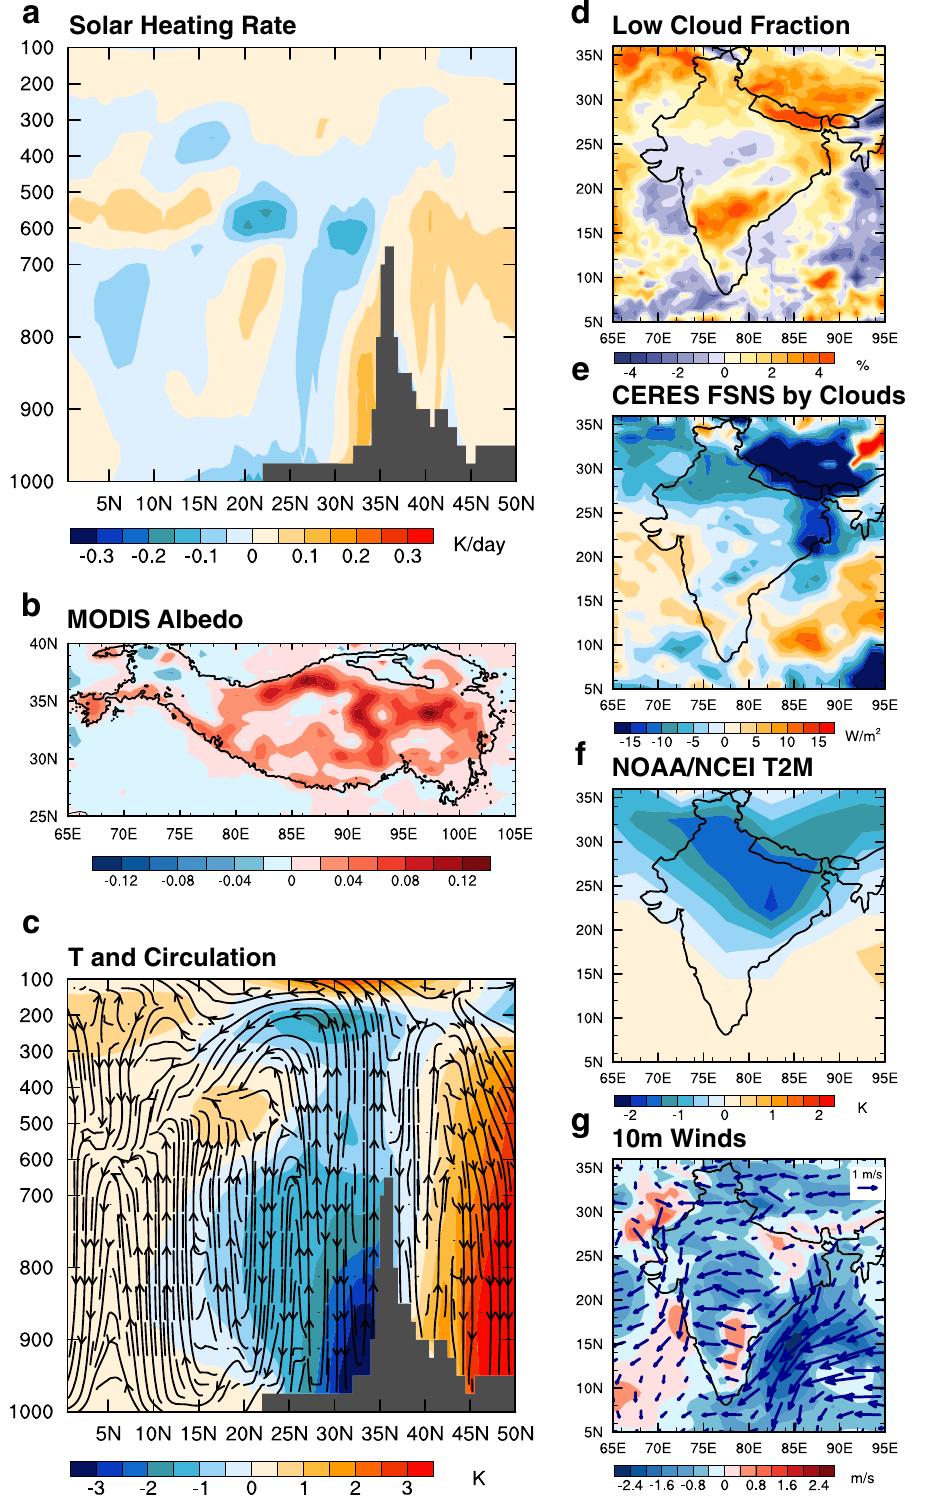
Fig. 2 BC induced climate anomalies in the premonsoon season of 2020 during the COVID-19 pandemic. a Zonal mean (70°E – 90°E) shortwave heating rate in MERRA-2. b Surface albedo in MODIS. c Zonal mean (70°E – 90°E) air temperature (contour fi ll) and stream function (vectors) in MERRA-2. d Low cloud fraction in MERRA-2. e Surface shortwave cloud radiative effect in CERES. f 2-m air temperature in NOAA/NCEI. g Winds at 10 m in MERRA-2. All anomalies are relative to 2015 – 2019 multiyear